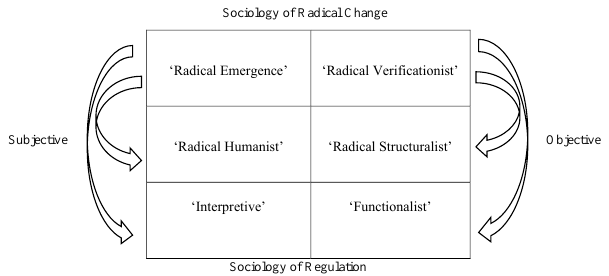
Figure 2: Modified Burrell and Morgan